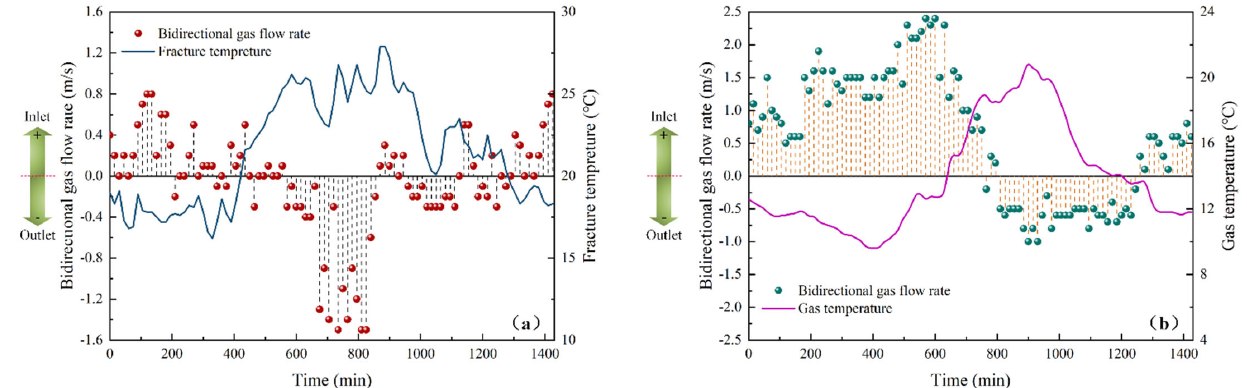
Figure 6. Time variation of the fissure channel’s thermophysical characteristics, which are divided into fissure temperature and bidirectional gas flow rate. ( a ) Research Site 1#; ( b ) Research Site 2#.